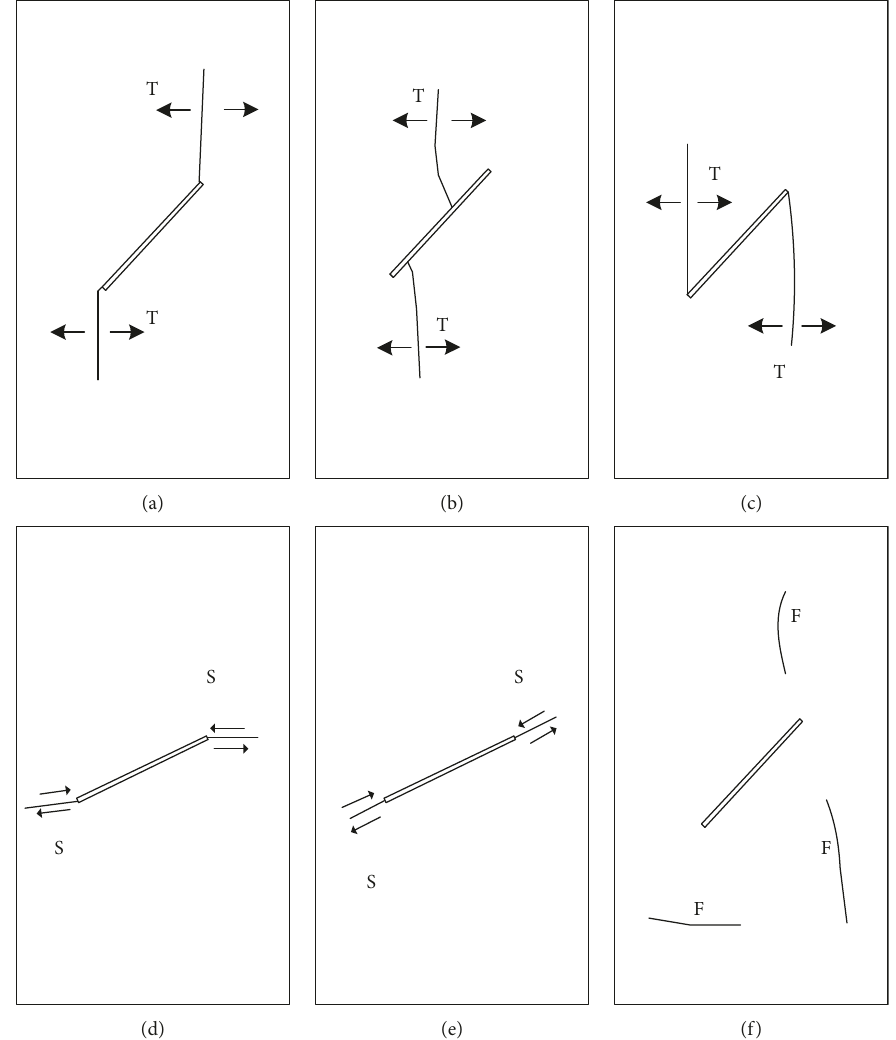
Figure 4: Crack types in the specimens with different bridge lengths and bridge angles: (a) tensile crack at the open flaw tip; (b) tensile crack at a position that is located close to the open flaw tip; (c) antitensile crack; (d) normal shear crack; (e) coplanar shear crack; (f) far-field